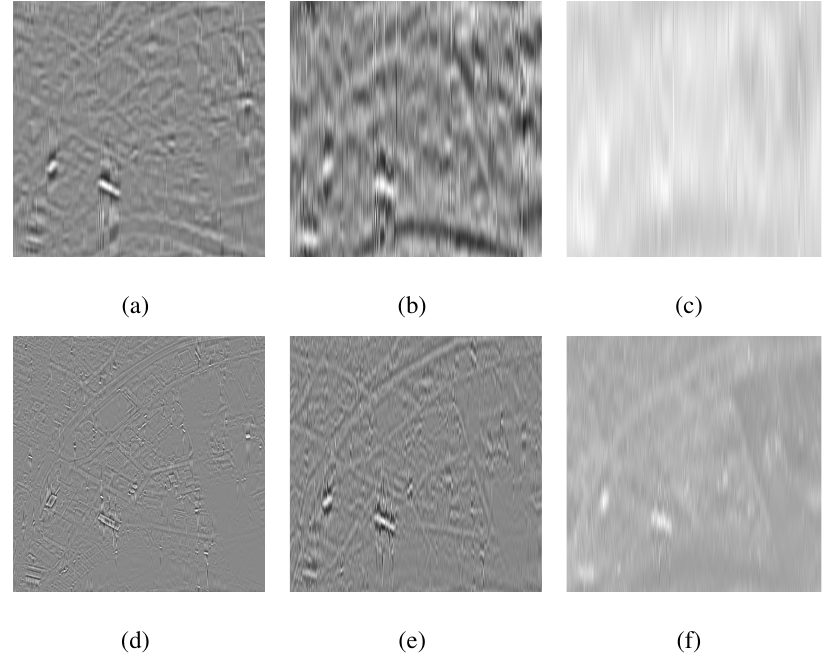
Figure 4. The intrinsic mode functions (IMFs) obtained by applying EMD on the I (top row) and the PAN images (bottom row), shown in Figure 3. ( a ) EMD IMF 1 − 4